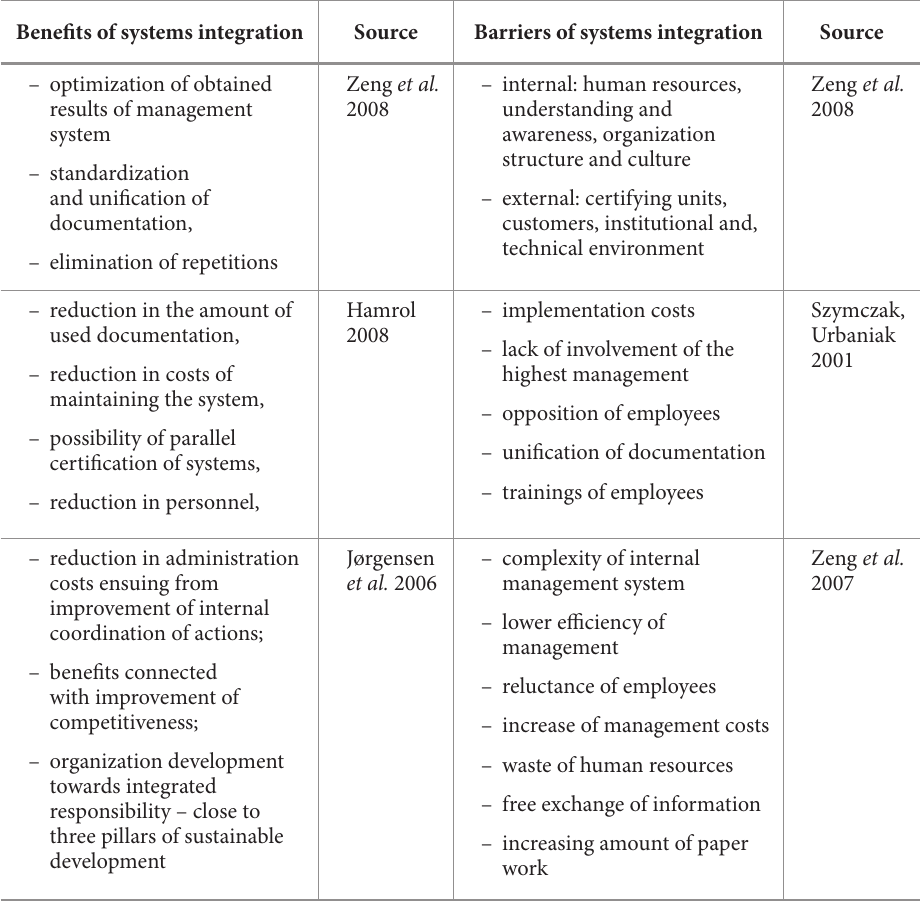
Table 5. Barriers and benefits related with integration of management